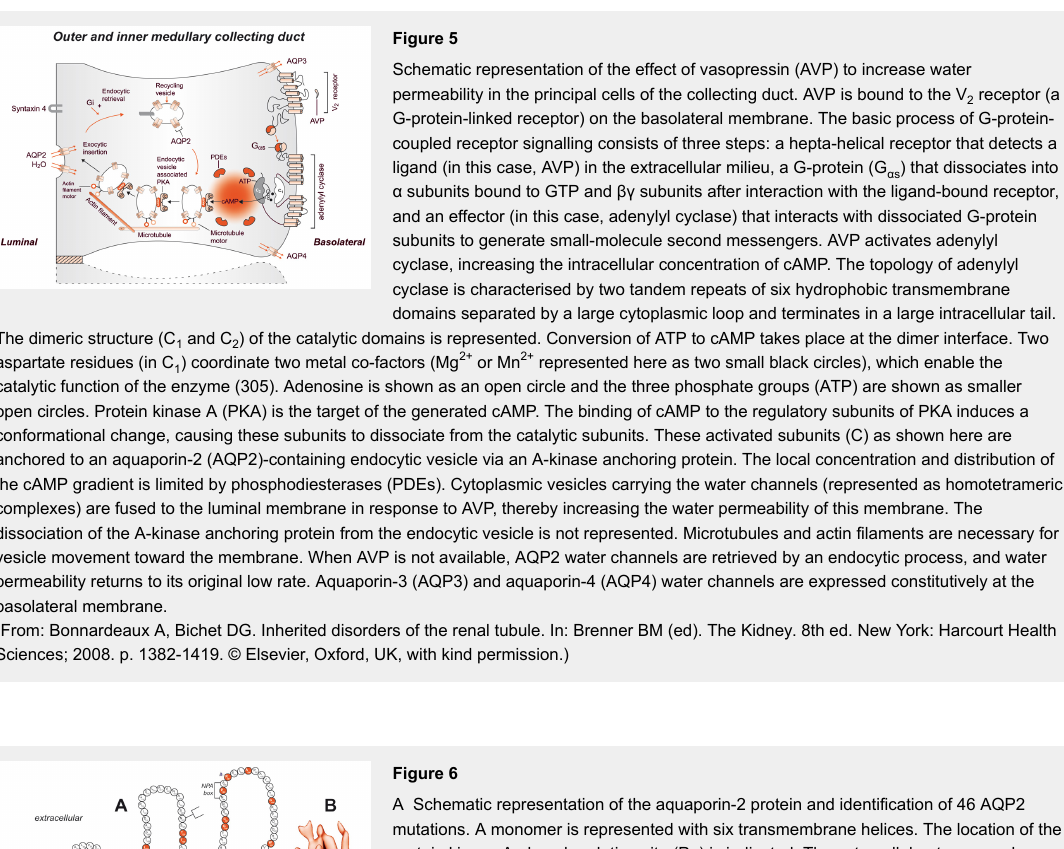
Figure 6 A Schematic representation of the aquaporin-2 protein and identification of 46 AQP2 mutations. A monomer is represented with six transmembrane helices. The location of the protein kinase A phosphorylation site (Pa) is indicated. The extracellular, transmembrane, and cytoplasmic domains are defined according to Deen et al. [82] Solid symbols indicate the mutations’ location. B A surface-shaded representation of the six-helix barrel of the AQP1 protein viewed parallel to the bilayer. (From: Bonnardeaux A, Bichet DG. Inherited disorders of the renal tubule. In: Brenner BM (ed). The Kidney. 8th ed. New York: Harcourt Health Sciences; 2008. p. 1382‒1419. © Elsevier, Oxford, UK, with kind